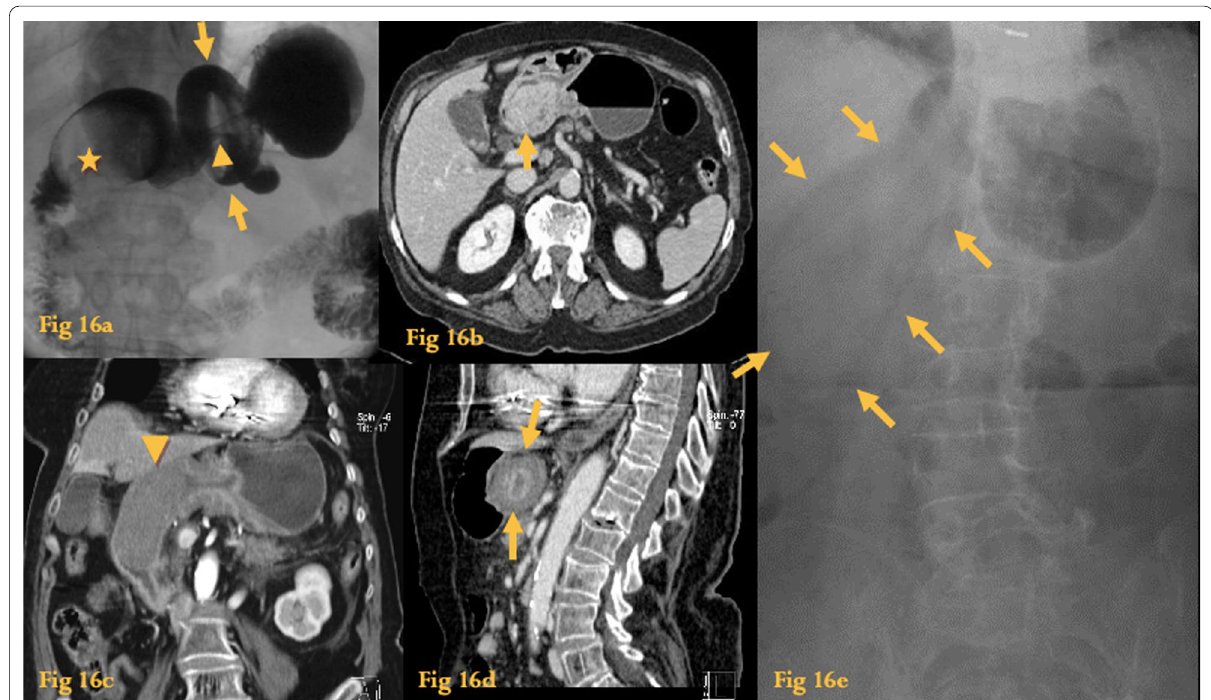
Fig. 16 Intussusception. UGIS ( a ) rounded filling defect in the lumen of the duodenal bulb (asterisk), with regular outlines. The telescoping of mucosal folds (arrowhead) and the prepyloric collar‑shaped outpouching (arrows) indicates this is an intussusception of a tumor from the gastric antrum. Abdominal CT ( b ) of the same patient with a prolapsing polypoid soft‑tissue density mass with slightly heterogeneous enhancement (arrow). This was a gastric GIST. Abdominal CT of another gastric GIST ( c , d ) prolapsing to the duodenum (arrowhead). The coronal reformation shows a typical “target‑like” appearance (arrows). Abdominal radiograph ( e ) of the same patient of 9 c , d )—Retrospectively, the intraduodenal mass well‑delineated by luminal air was already evident